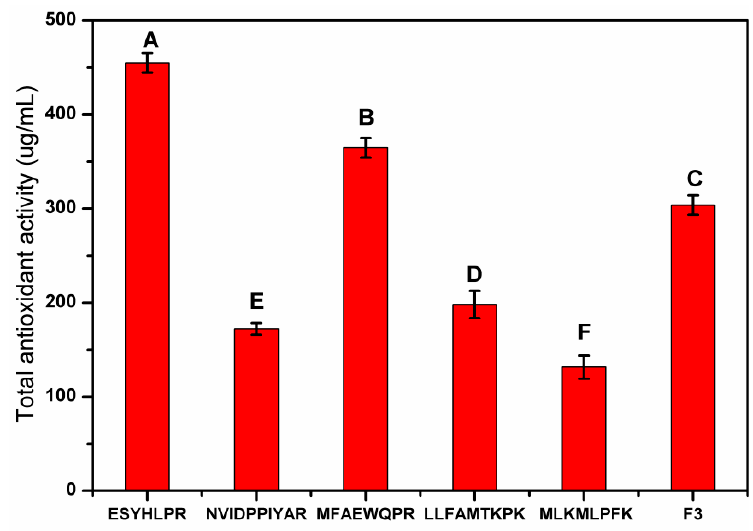
Figure 7. Determination of total antioxidant activity of five predicted peptides. The different capital letters indicate significant differences ( p < 0.05).